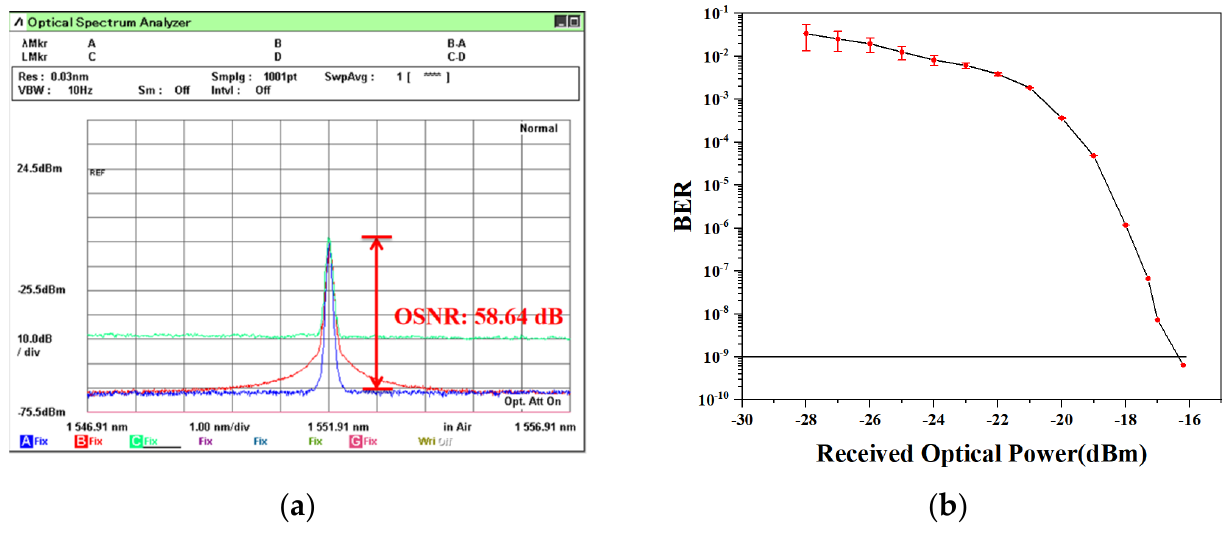
Figure 9. ( a ) OSNR of fiber laser before and after the EDFA. ( b )BER performance of the proposed extra narrow linewidth fiber laser.